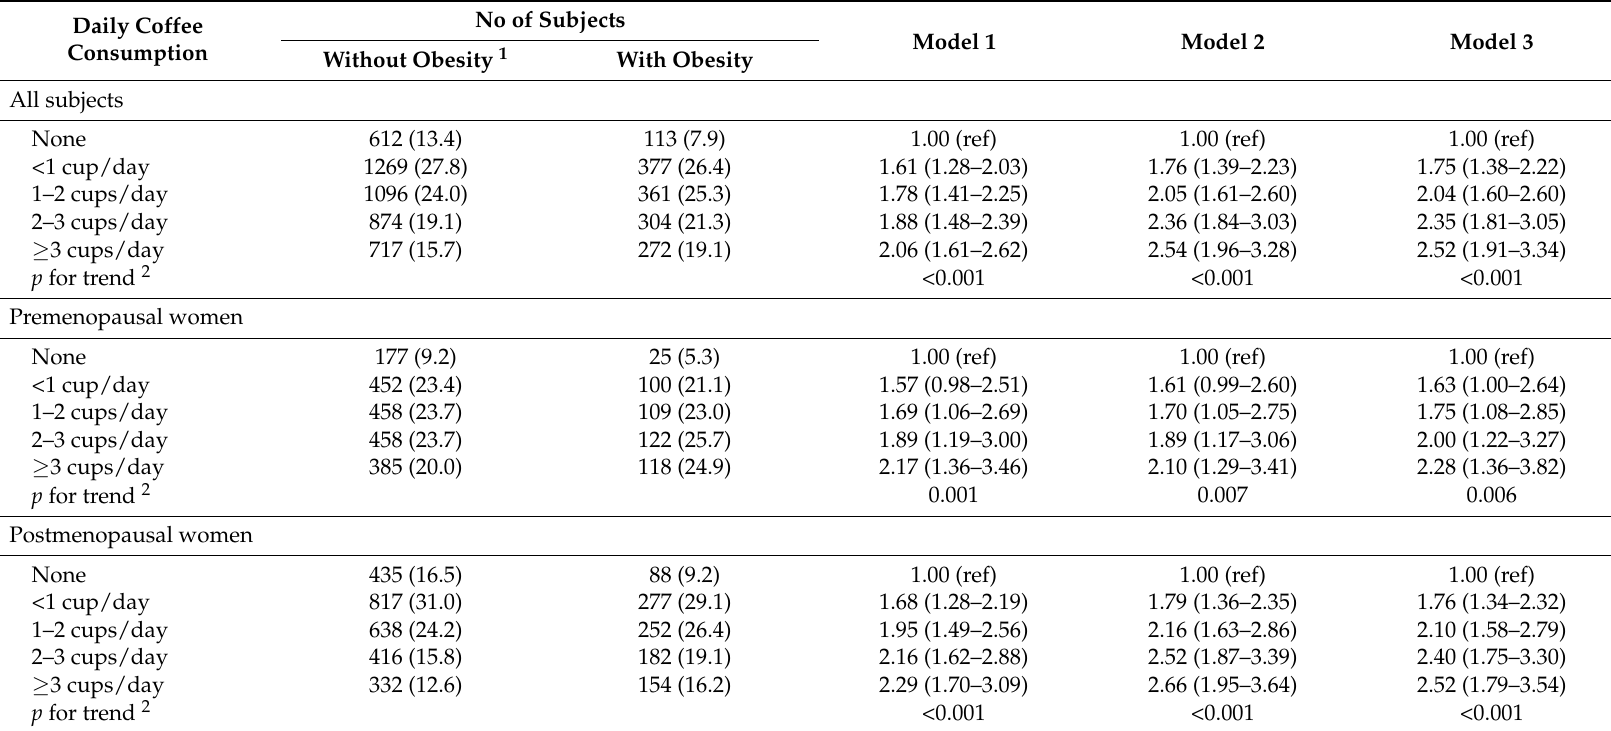
Table 3. Odds ratio (OR) and 95% confidence interval (CI) for the prevalence of obesity as defined by body mass index ( ≥ 25) according to coffee consumption